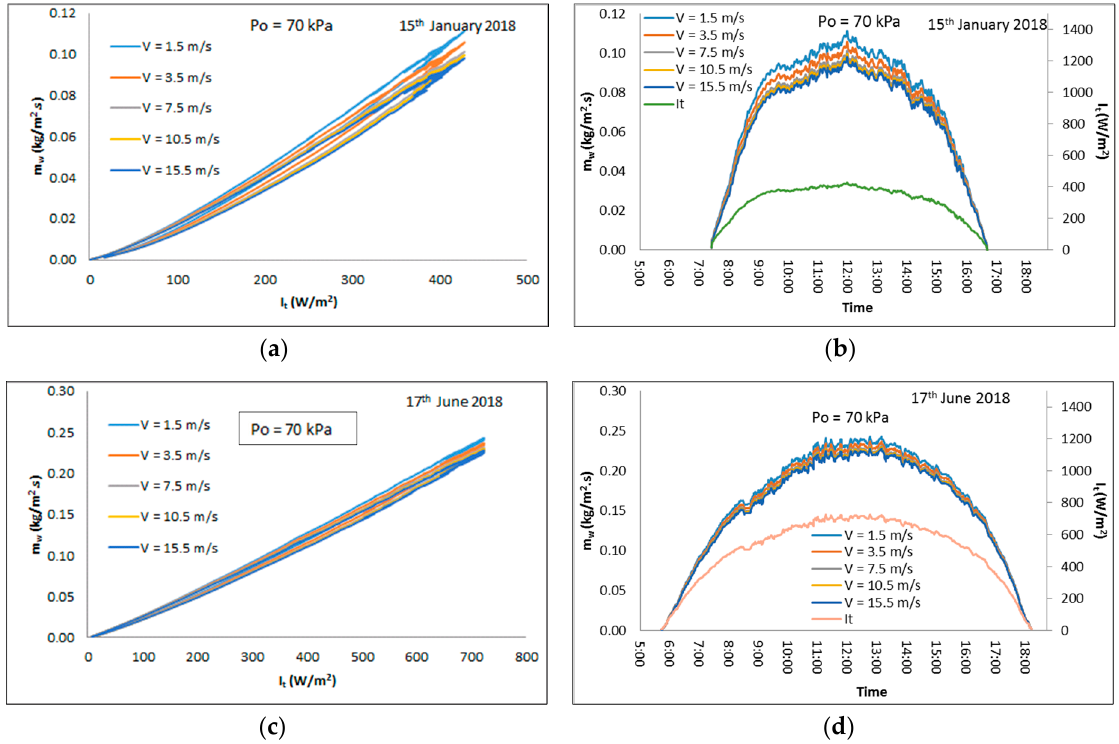
Figure 9. Effect of wind speed on the production of a geothermal solar still. ( a , b ) represent analysis for